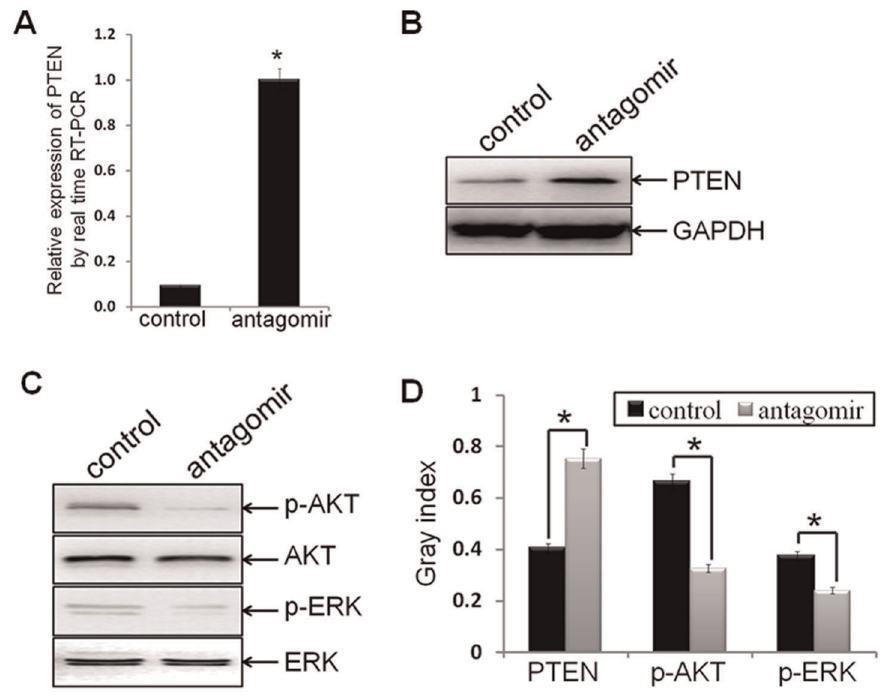
Figure 3. Antagonism of miR-21 induced the expression of PTEN, as well as inactivated AKT and ERK1/2. (A) Ectopic expression of PTEN mRNA in MDA-MB-231/anti-miR-21 cells and MDA-MB-231/control cells were verified by real time RT-PCR assay (p=0.003). (B, C, D) Protein levels of PTEN, p-AKT, AKT, p-ERK1/2, and ERK1/2 in indicated cells were detected by Western blot analysis, and bands were semi-quantified using ImageJ software. GAPDH was used as loading control. (*indicates p , 0.05).